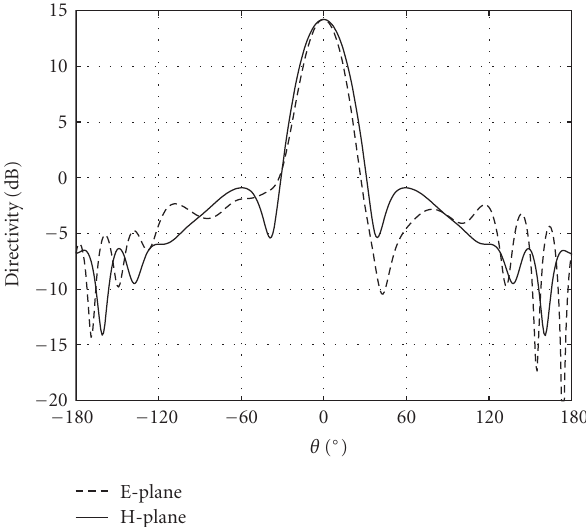
Figure 10: Radiation patterns at the upper end frequency (5.5GHz) of the operating bandwidth in the E- and